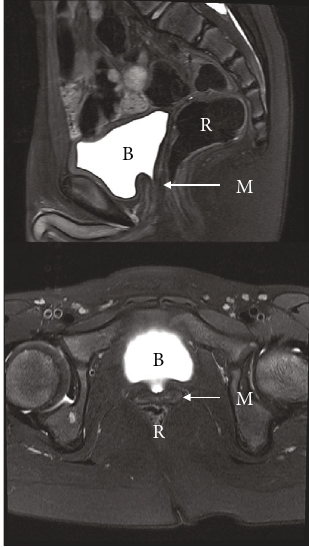
Figure 3: Magnetic resonance imaging (MRI) sagittal and axial views showing Müllerian remnant. Key: M: Müllerian remnant; B: bladder; R: rectum.